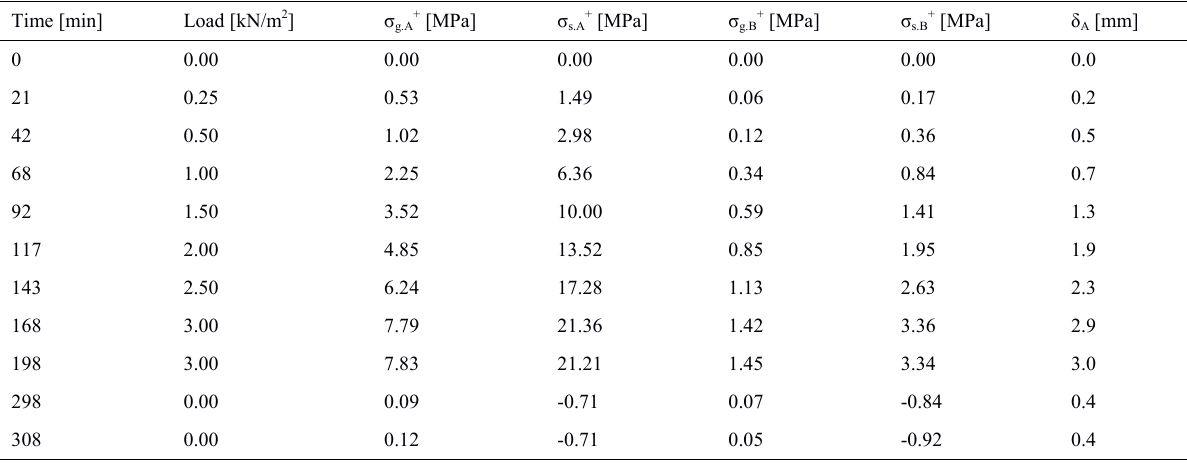
Table 8: Stresses and vertical displacement obtained during the load testing.